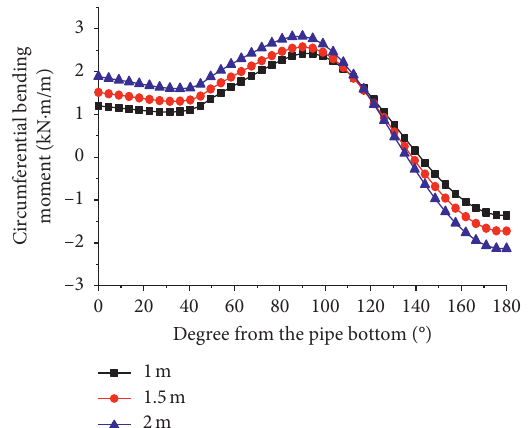
Figure 13: Circumferential bending moments at different buried depths.